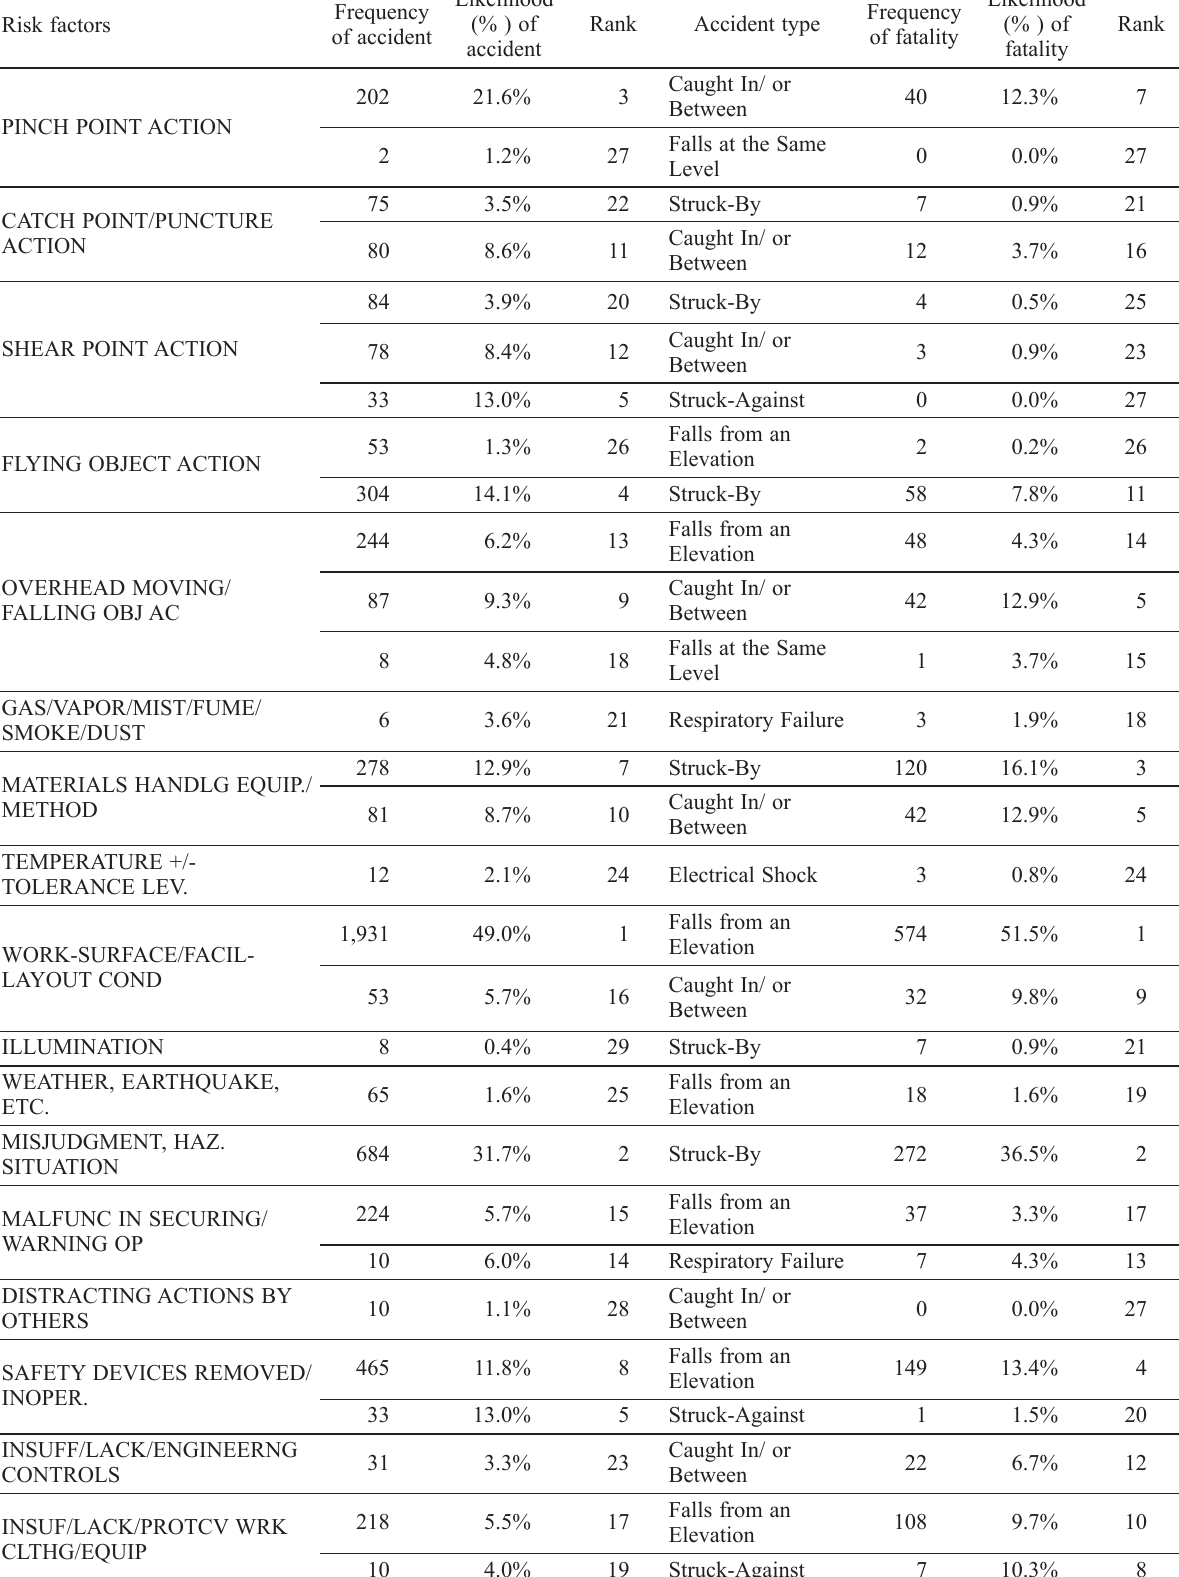
Table 6. Impact of key risk factors on accident and fatality